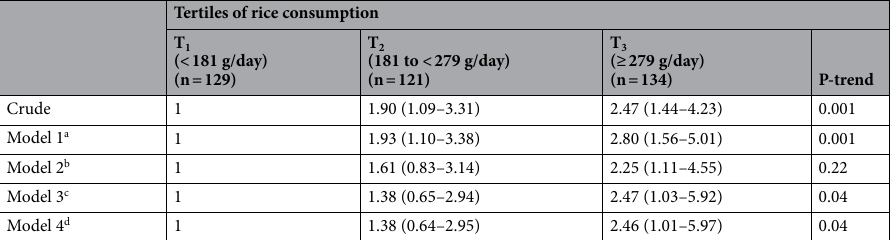
Table 3. Multivariable-adjusted odds ratios and 95% CIs for glioma across tertiles of rice consumption. a Model 1: adjusted for age, gender and energy intake. b Model 2: further adjustments were done for physical activity, family history of cancer, family history of glioma, marital status, education, high risk occupation, high risk residential area, duration of cell phone use, supplement use, History of exposure to the radiographic x-ray, history of head trauma, history of allergy, history of hypertension, smoking, exposure to chemicals, drug use, personal hair dye use, frequent fried food intake, frequent use of barbecue, canned foods and microwave. c Model 3: further adjusted for dietary intake of whole grains, red and processed meats, fruits, vegetables, white meats, legumes and nuts, and dietary fat, refined grain (except for rice) and caffeine. d Model 4: additionally adjusted for